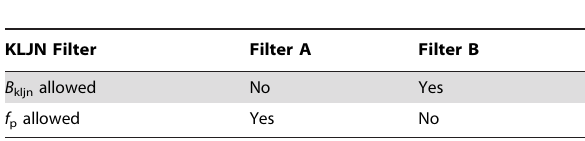
Table 3. Truth table of left KLJN filter when a host is in State 2 (active